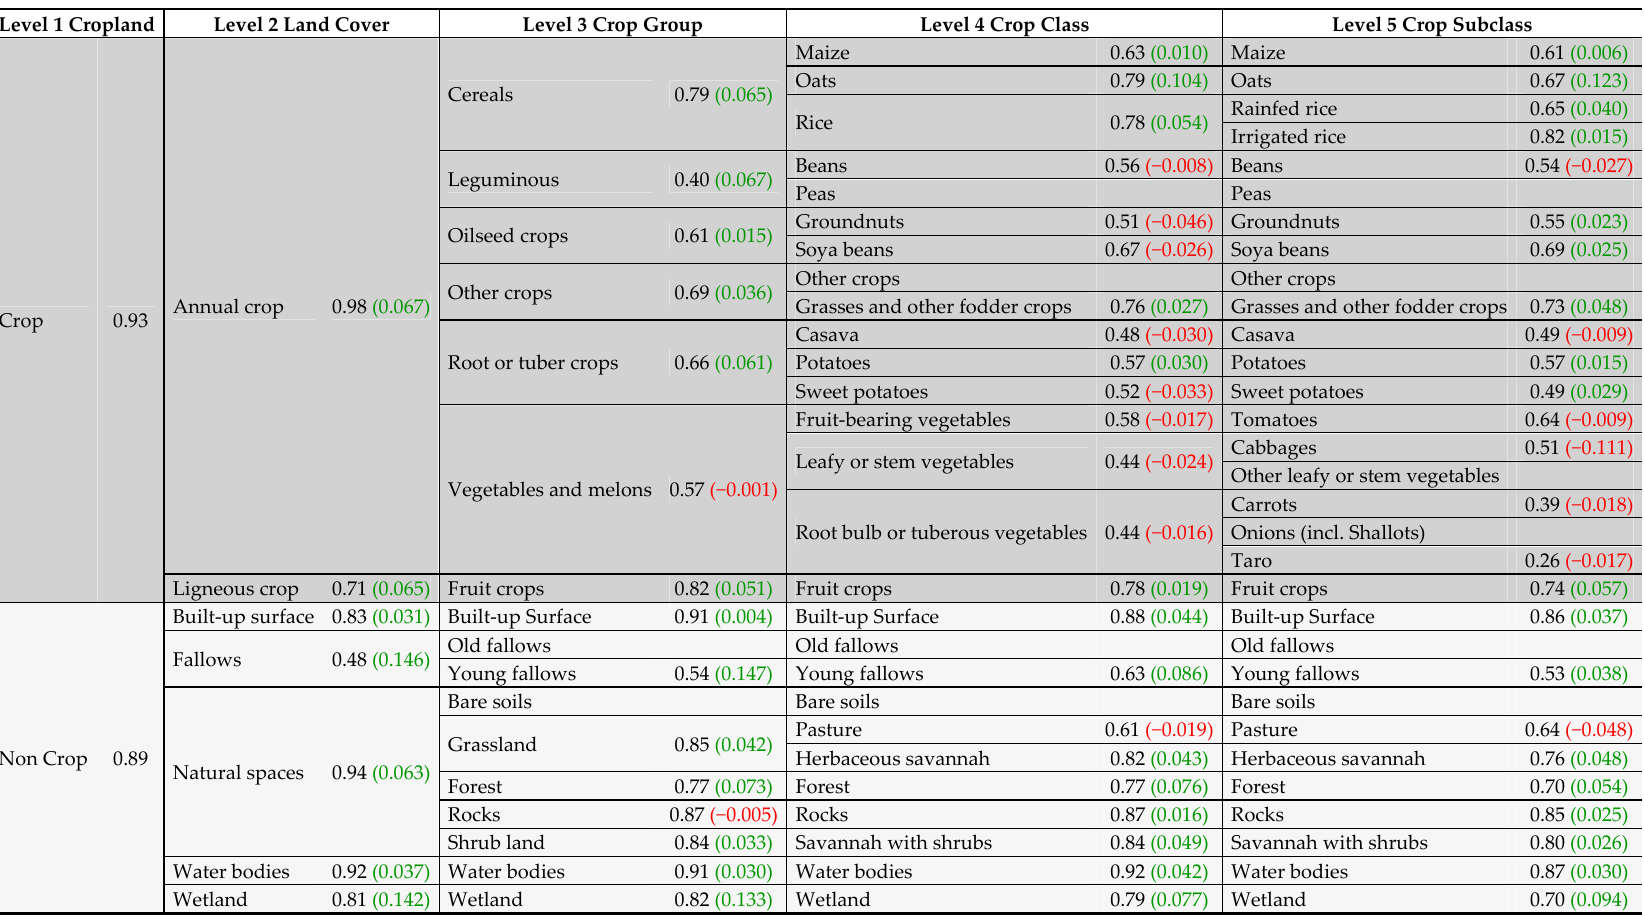
Table 5. Class f1-scores obtained via the hierarchical approach. Differences in class f1-scores between the hierarchical and classical approaches at different nomenclature levels are shown in brackets. Positive values are shown in green (the hierarchical approach is superior to the classical approach) and negative values are shown in red (the classical approach is superior to the hierarchical